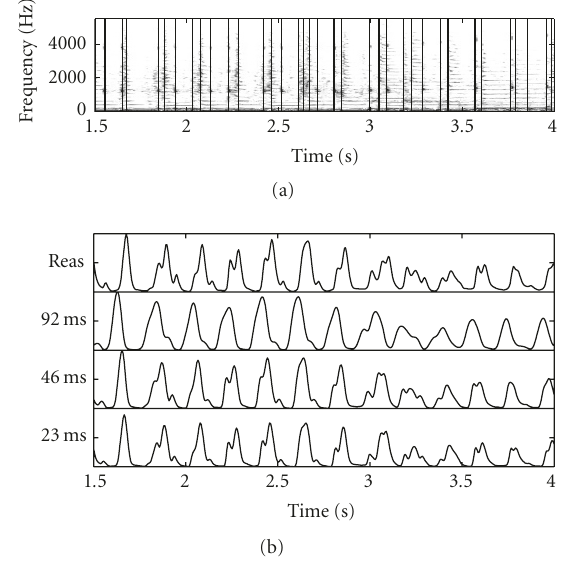
Figure 2: From top to bottom: (a) reassigned spectrogram com- puted using a window length of 92 . 8 ms, superimposed: manually annotated onset locations, (b1) corresponding reassigned spectral energy flux function, (b2) normal spectral energy flux function computed using a window length of 92 ms, (b3) 46ms, (b4) 23ms on [signal: Asian Dub Foundation, RAFI, track 01 “Assassin” from the “songs” database of the ISMIR 2004 test